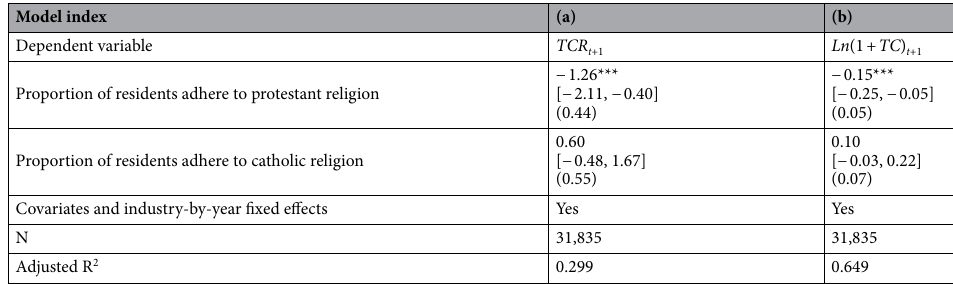
Table 4. Diverse relationships between the degree of affiliation with particular religious denominations and workplace injury. Column (a) of Table 4 displays statistics from models that regressed each private-sector establishment’s Total Case Rate of injuries, illnesses, and deaths (TCR)—as recorded by the United States Occupational Safety and Health Administration (OSHA) 40 from 2002 to 2011—on its county’s proportion of residents acknowledging a religious adherence to, respectively, the Protestant Christian religion and the Catholic Christian religion 30,33,34 . Column (b) reports a regression of the natural logarithm of one plus Total Cases of injuries, illnesses, and deaths (TC) 40 on those same variables. All models include covariates and industry-by-year fixed effects, with the complete coefficient estimates for all covariates reported in the supplementary information. The second to last row lists the number of observations (N) and the final row displays the proportion of explained variance (R 2 ), adjusted for covariates. Asterisks denote the level of